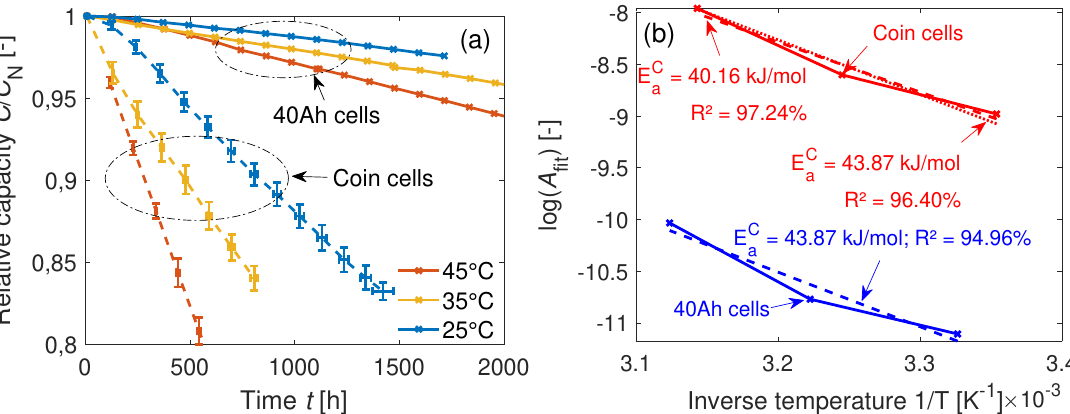
Figure 7. ( a ) Relative capacity during cyclic aging of the 40Ah cells and the coin cells. The temperatures measured at the surfaces of the coin cells during cycling are identical to the set temperatures of the climate chambers T coin ∈ [ 45,35,25 ] ◦ C. The averaged surface temperatures of the 40Ah cells during cycling are µ T ∈ [ 47.0,37.2,27.5 ] ◦ C. ( b ) Temperature-dependent reaction rates A fit ( T ) derived from the fit functions. The corresponding activation energies of the capacity degradation E a,C are the same for both cell types with terms of the measurement uncertainty, which means a similar temperature-dependent degradation